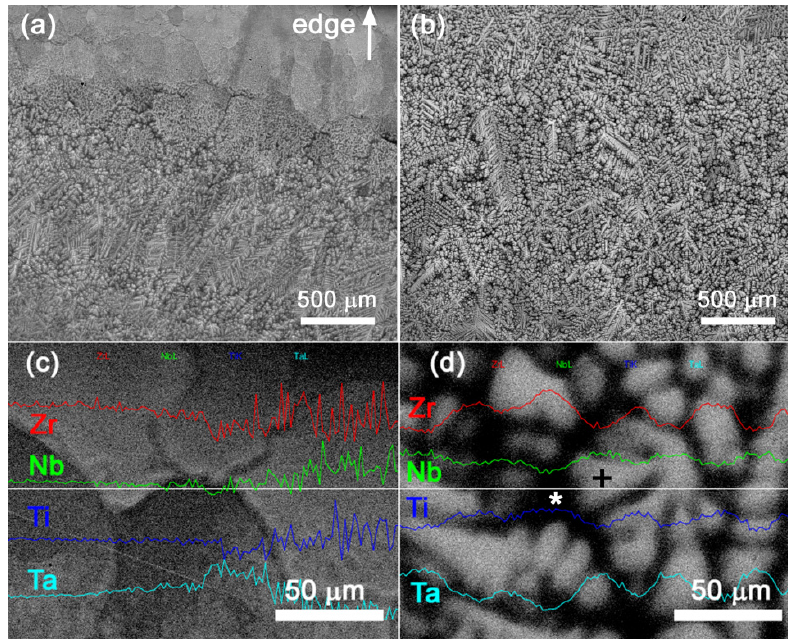
Figure 2. SEM micrographs (back-scattered electrons) and results of the EDS analysis of NbTaTiZr alloy in the as-cast state: ( a ) edge of the ingot is on top of the figure; ( b ) center of the ingot, ( c ) EDS line scan with the concentration profile at the edge of the ingot, ( d ) EDS line scan in the center of the ingot. The position of the line scan is indicated by the horizontal white line. Regions used for EDS point scans in order to determine the composition of Ti, Zr and Nb, Ta-rich phases are denoted by star and cross symbols, respectively.